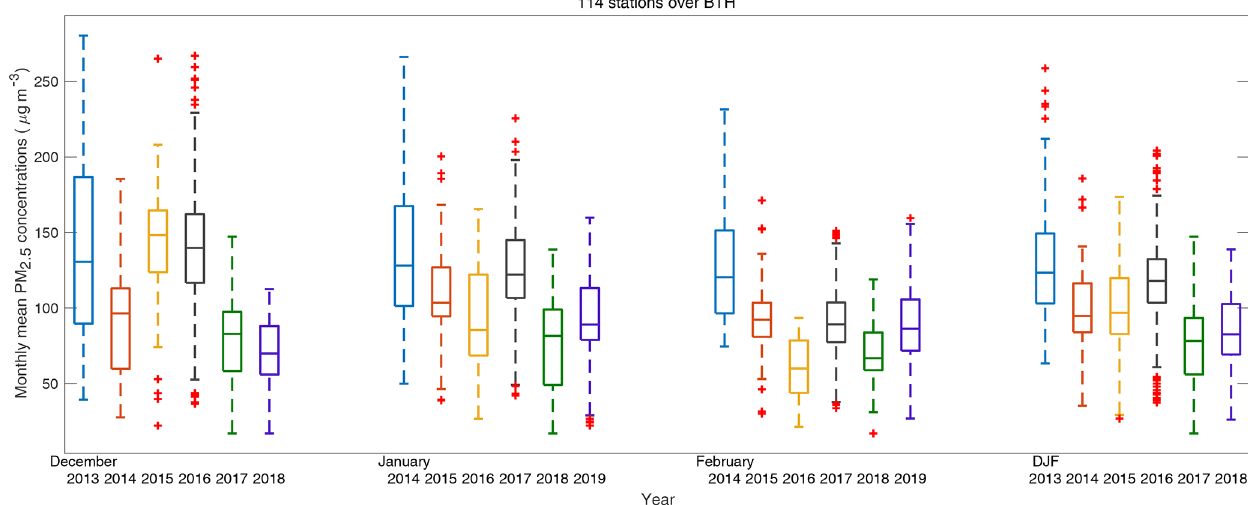
Figure 1. Interannual variation in the wintertime PM 2 . 5 concentrations at 114 stations over the BTH region. In each box, the central mark indicates the median, and the bottom and top edges of the box indicate the 25th and 75th percentiles, respectively. The whiskers extending to the most extreme data points are considered outliers. The region covered by the blue box in Fig. 2 is considered as the BTH region (36–42 ◦ N and 113–117.5 ◦ E). Table 1. The seasonal mean and median PM 2 . 5 concentrations in each atmospheric circulation type (CT) over the BTH region. PM 2 . 5 concentrations in bold represent the mean/median value of each CT lower than the all-case seasonal mean/median value. Seasonal mean/median CT1 CT2 CT3 CT4 CT5